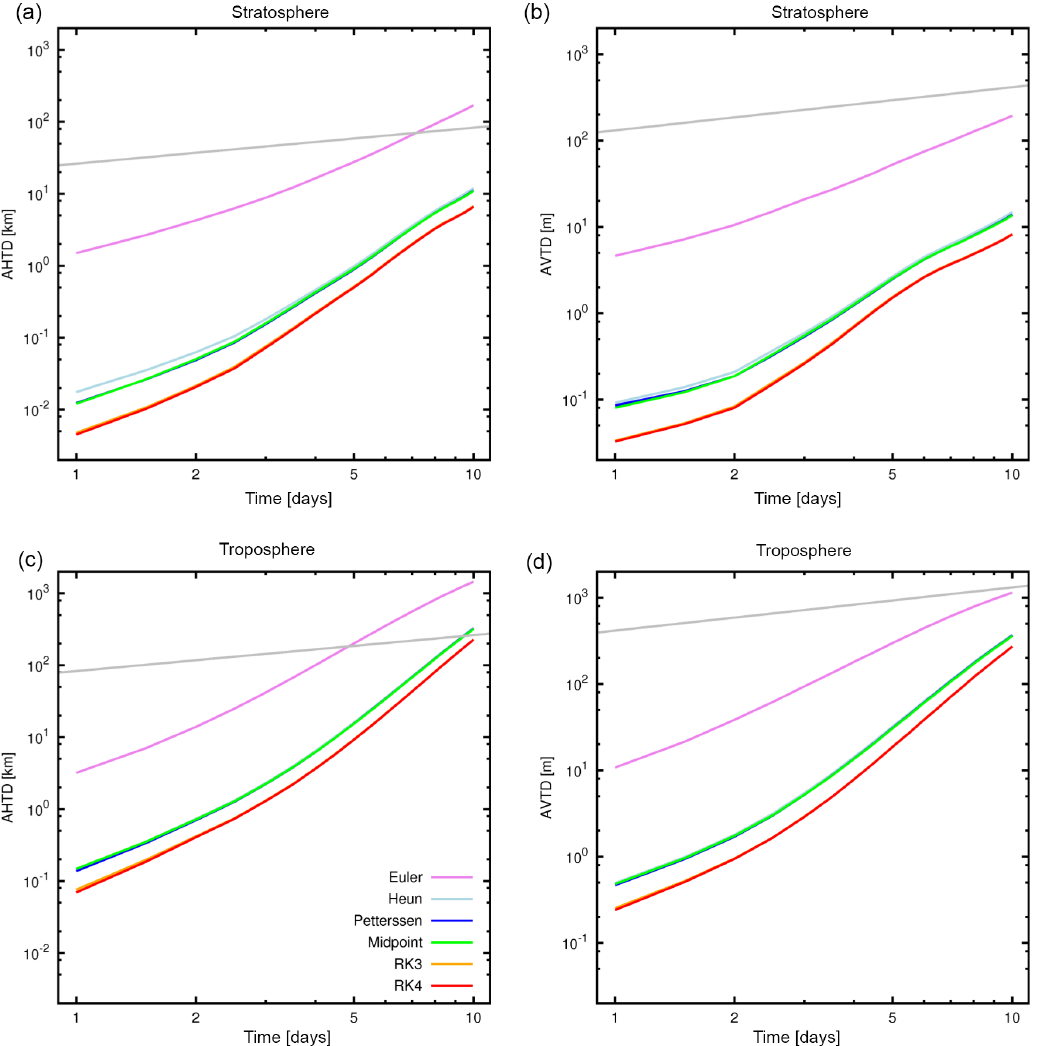
Figure 4. Absolute horizontal (a, c) and vertical (b, d) transport deviations of trajectory calculations for the stratosphere (a, b) and tropo- sphere (c, d) . The trajectory calculations are based on different numerical schemes but use the same time step ( (cid:49)t = 120s). Grey lines show error limits based on particle